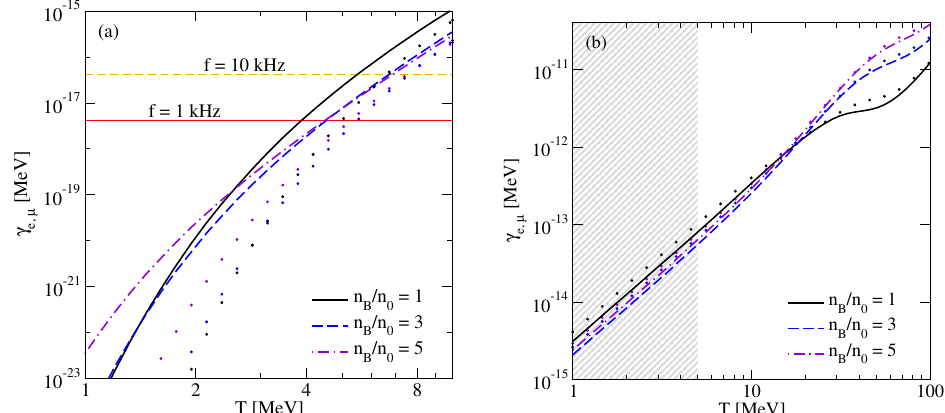
Figure 7. The relaxation rates γ e (solid, dashed, and dash-dotted lines) and γ µ (dotted lines) of Urca processes as functions of the temperature for fixed values of the density for ( a ) neutrino-transparent matter; ( b ) neutrino-trapped matter, where the shaded area shows the extrapolation of the result to the temperature regime T ≤ 5 MeV, where the trapping assumption fails. The horizontal lines in panel ( a ) correspond to the fixed values of oscillation frequency f = 1 kHz (solid line) and f = 10 kHz (dashed line).